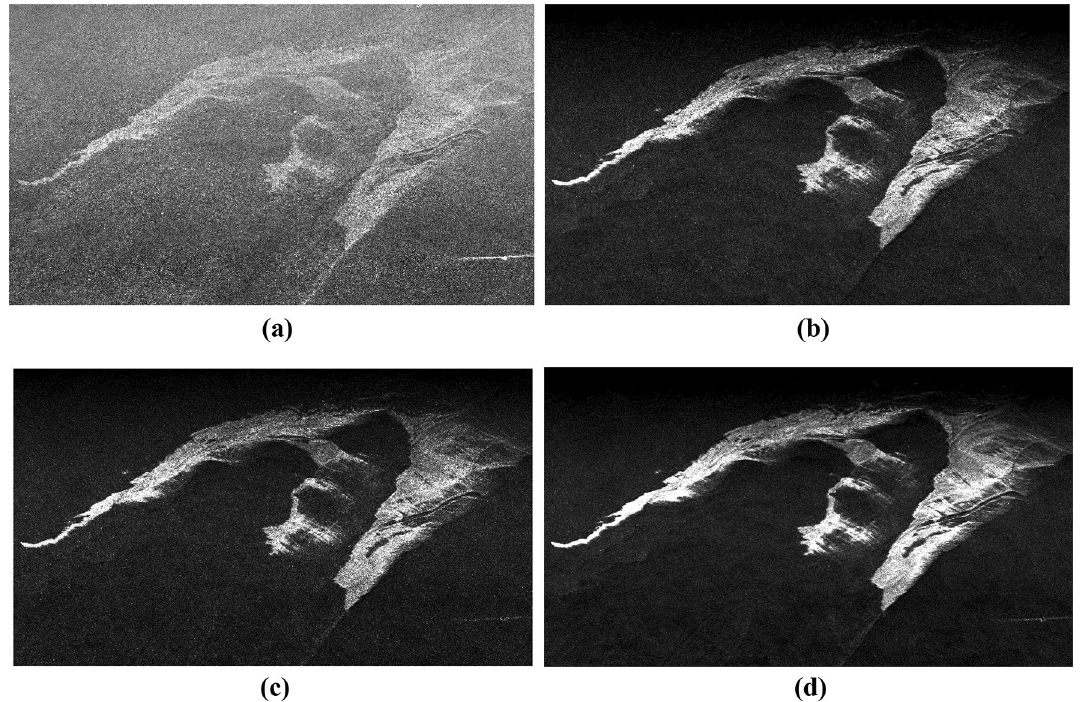
Figure 6. Figure showing parameters ( a ) CPR, ( b ) DR, ( c ) CPR*DR, (d) CPR*DR after applying a 3 × 3 low pass